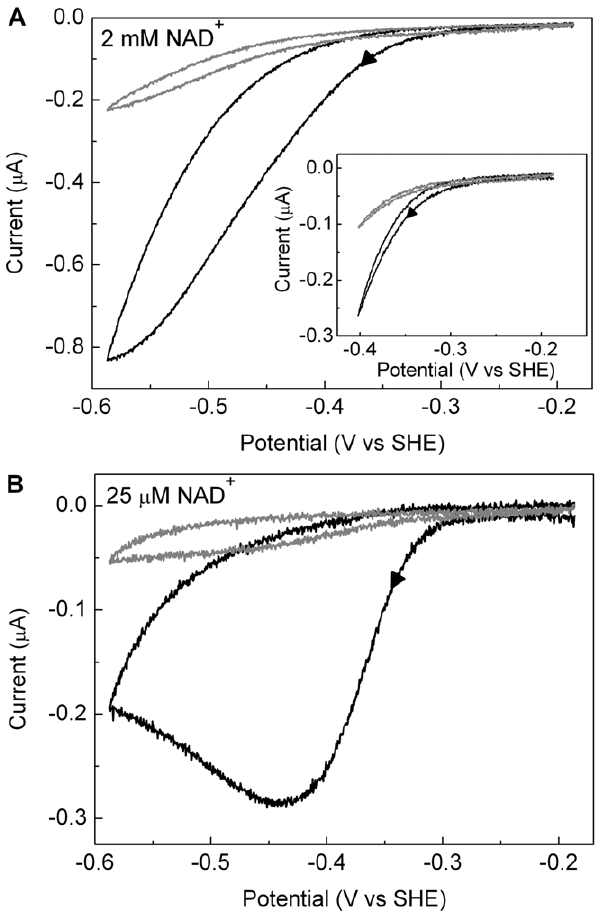
Figure 8. Ability of HoxFU to (A) oxidize NADH and (B) reduce NAD + in the presence of O 2 . In panel A, the potential was held at 243 mV so that the enzyme film oxidises NADH. The drop in current throughout the experiment is attributed to enzyme dissociation from the electrode. An aliquot of air-saturated solution was introduced as indicated. Panel B shows a series of cyclic voltammetric experiments recorded at a scan rate of 1 mV/s with the electrode rotated at 2500 rpm in a solution of 50 mM TrisHCl pH 8.0 containing 25 m M NAD + . The solid black line shows the response for a HoxFU film as the potential is swept from 2 0.2 V to 2 0.6 V. The blue line shows the response for an unmodified electrode, as O 2 is introduced into the solution during the forward scan as indicated. The red line shows the response when the same amount of O 2 is introduced during a potential cycle for an electrode modified with a fresh film of HoxFU (normalized to the current magnitude of the black forward trace at 2 300 mV). Subtraction of the blue trace (contribution from direct O 2 reduction) from the red trace yields the thin black trace which is similar in shape to the solid black trace, confirming that the characteristic shape of the HoxFU electrocatalytic wave is retained in the presence of O 2 .